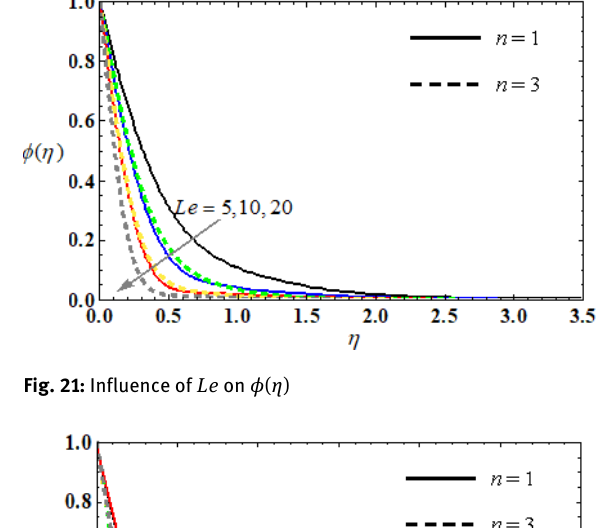
Fig. 21: Influence of Le on ϕ ( η )